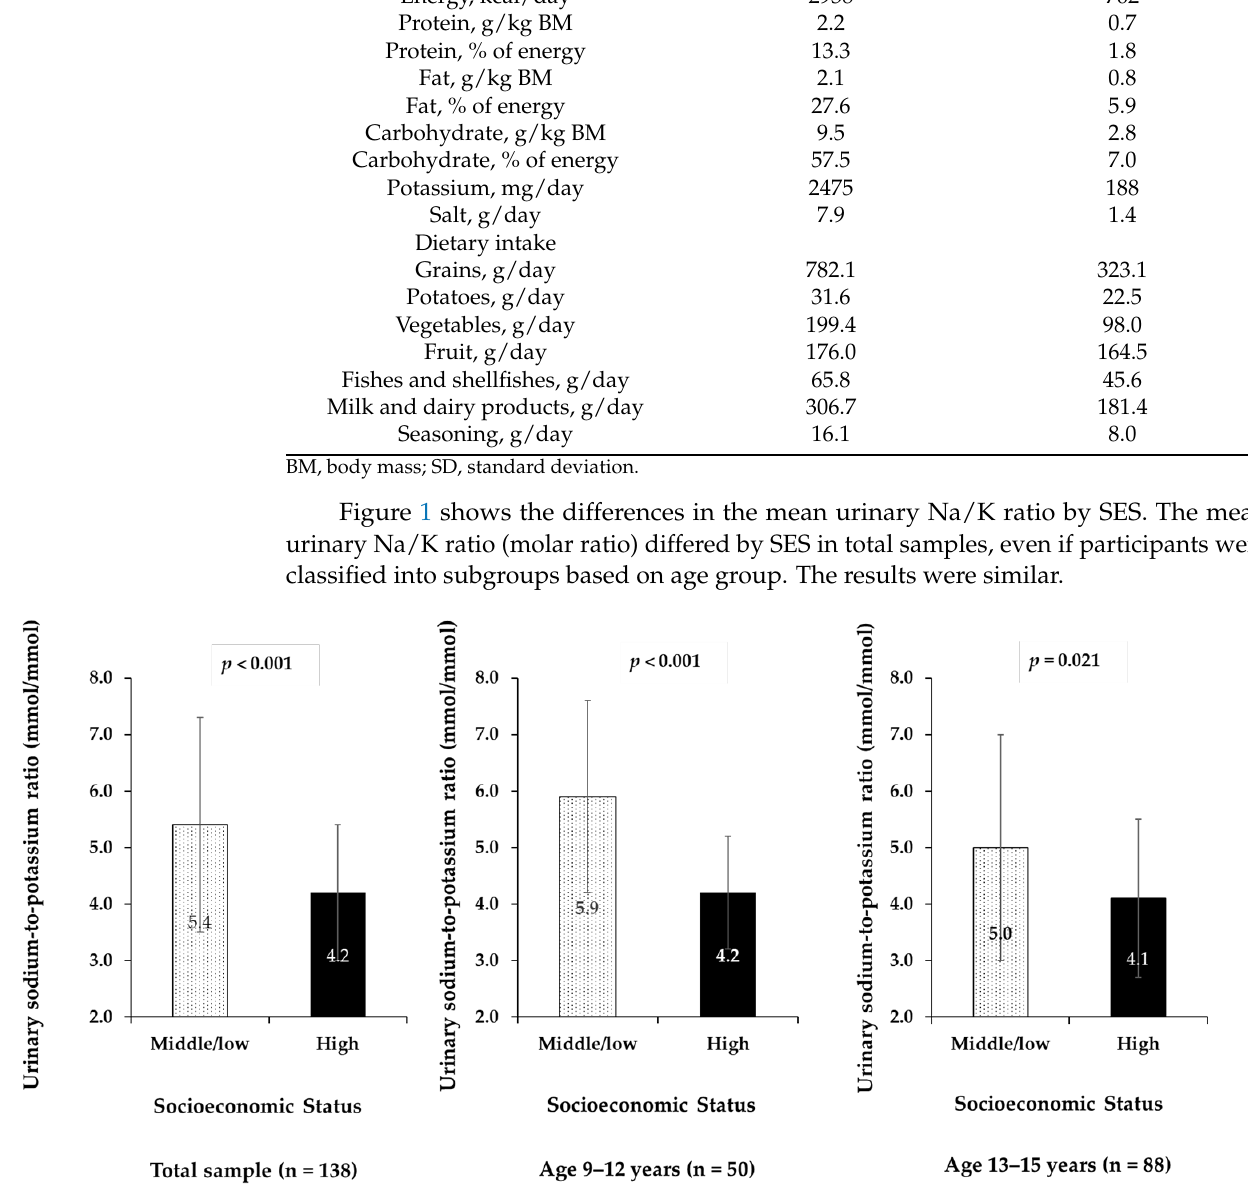
Table 4. Associations between the socioeconomic status and the urinary Na/K ratio by age group.